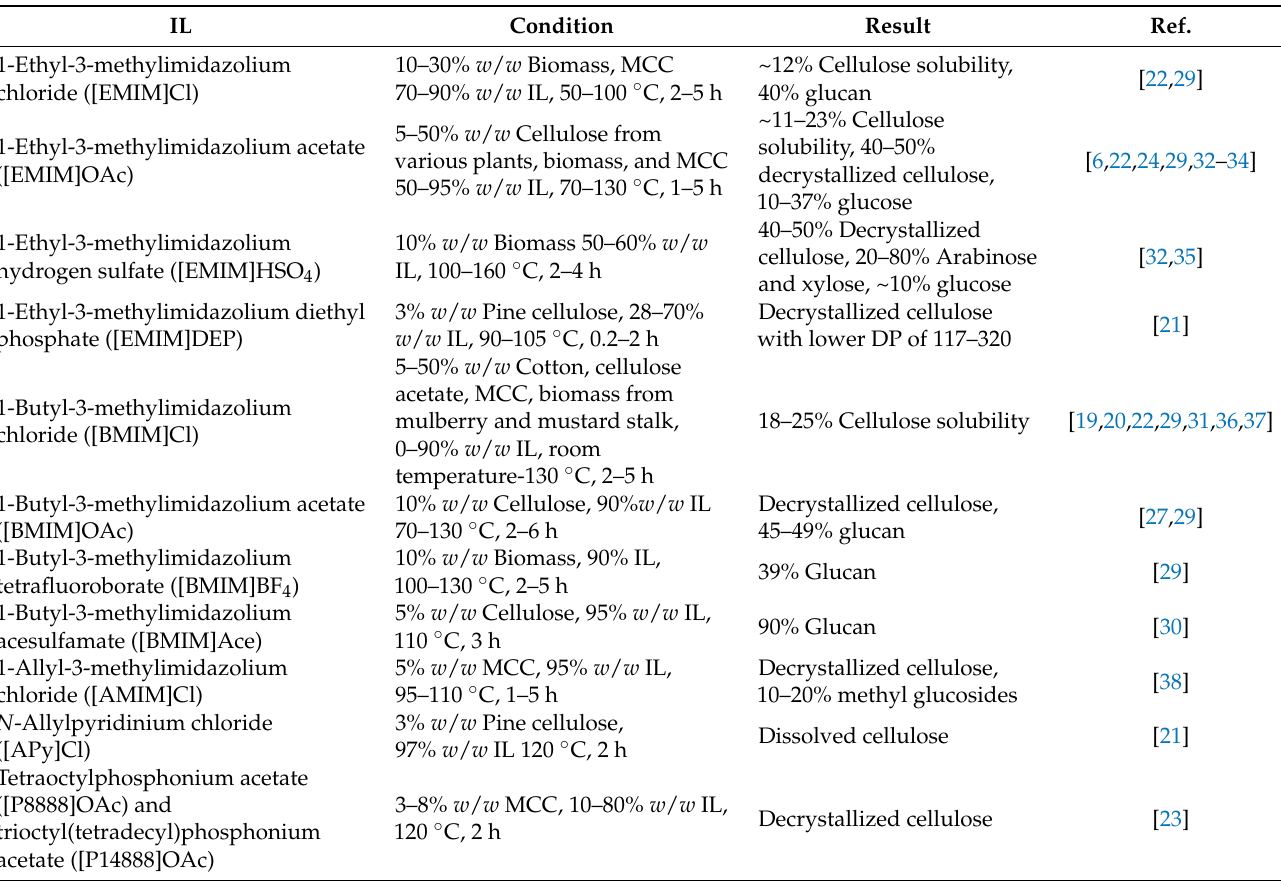
Table 1. Recent ILs used in pretreatment and hydrolysis of